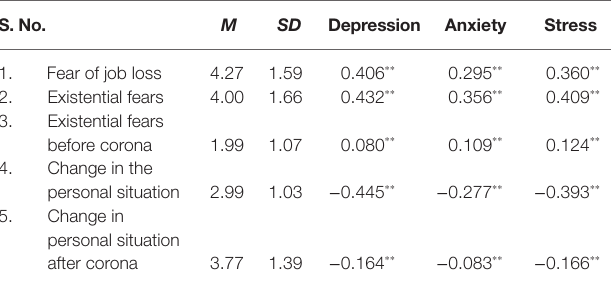
TABLE 2 | Correlation between DASS-scores and subjective evaluations, sample 2 April 2020. S.